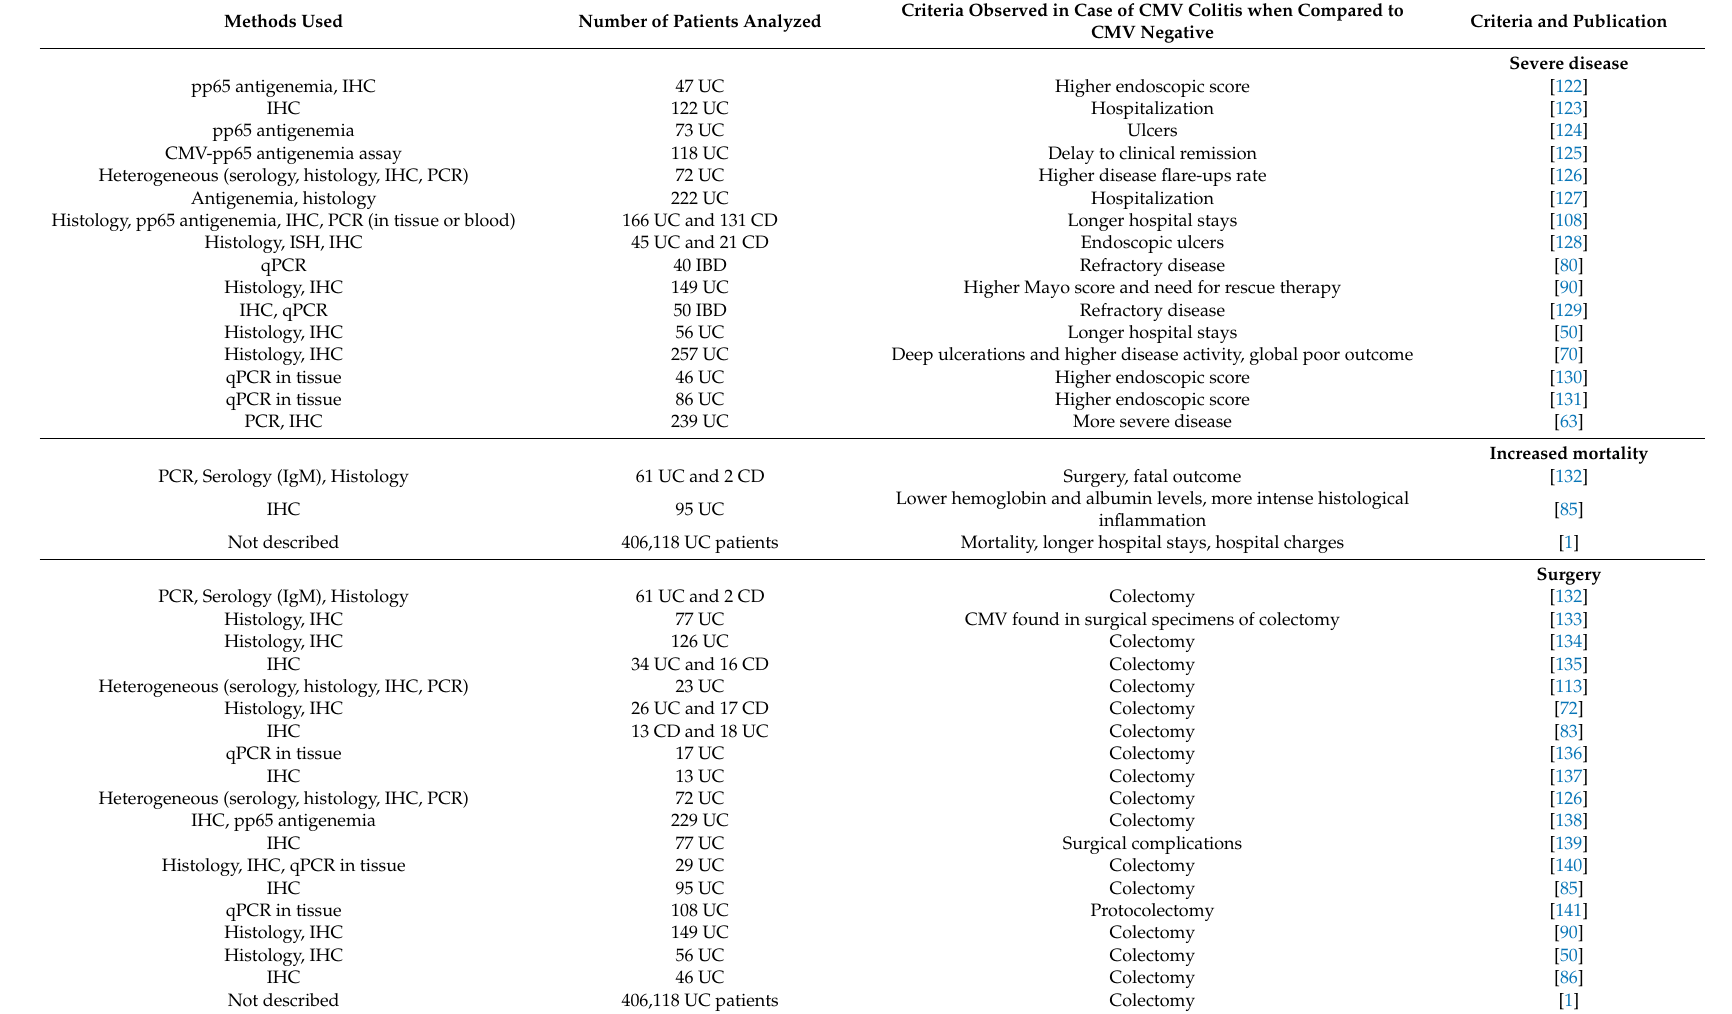
Table 3. Evidences for the pathogenic role of CMV in ulcerative colitis (UC) patients. Methods